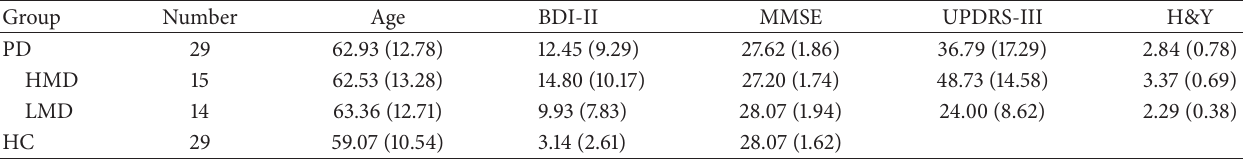
Table 2: Means (standard deviations) for demographic and clinical characteristics of PD patients and healthy controls in Experiment 1.